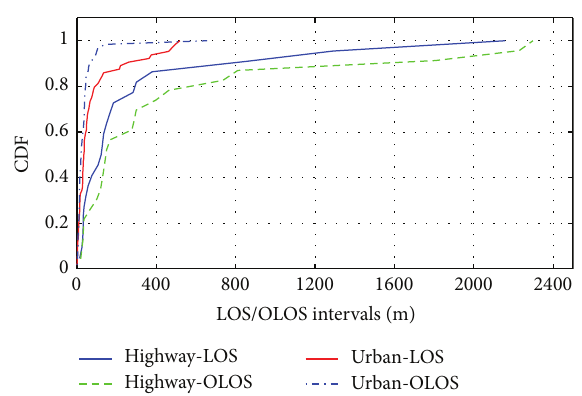
Figure 3: Cumulative Distribution Function (CDF) of LOS and OLOS distance intervals for all measurements: (a) highway scenario and (b) urban scenarios.